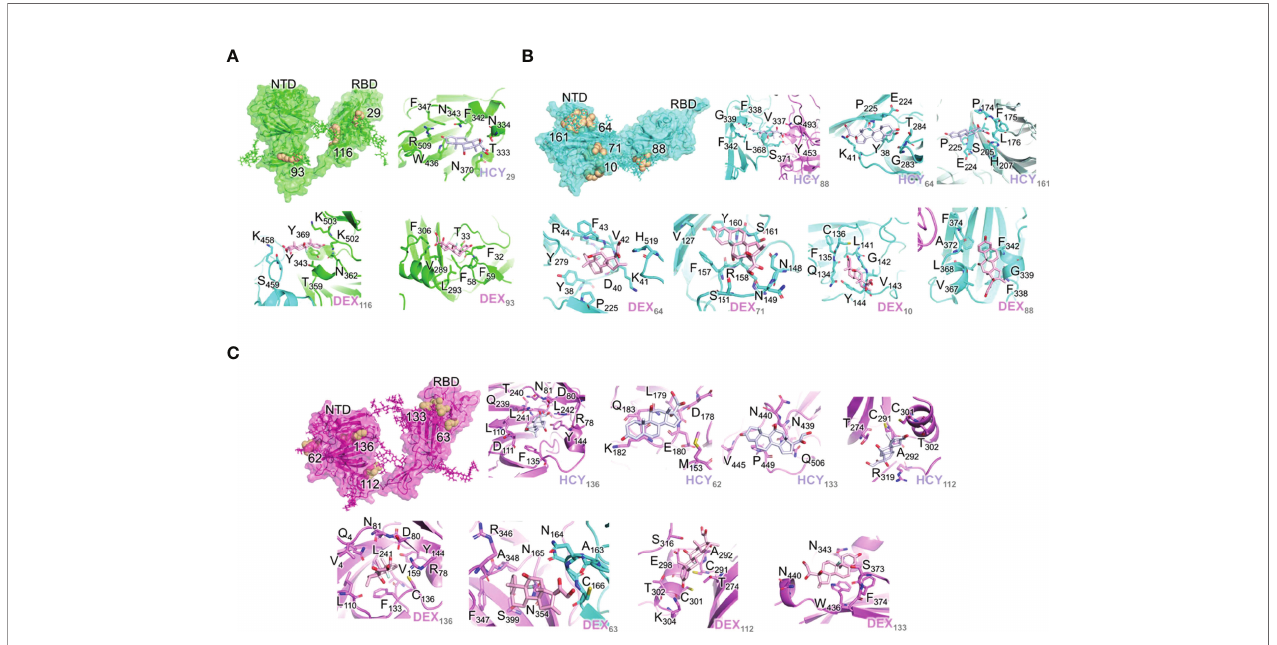
FIGURE 1 | Interactions of the ligand/pocket pairs in chain A (green), chain B (cyan) and chain C (magenta) of the S1 protein . (A) The pockets on each chain A were ranked according to the binding af fi nity. The pockets where the ligands are predicted to bind with a higher af fi nity (>13 kcal/mol) after MD simulation are shown ( Table 1 ). From left to right: High af fi nity binding pockets for cortisol and dexamethasone; Cortisol pocket 29; Dexamethasone pocket 116; Dexamethasone pocket 93. (B) The pockets on chain B were ranked according to the binding af fi nity. The pockets where the ligands are predicted to bind with a higher af fi nity (>13 kcal/ mol) after MD simulation are shown ( Table 3 ). From left to right: High af fi nity binding pockets for cortisol and dexamethasone; Cortisol pocket 88; Cortisol pocket 64; Cortisol pocket 161; Dexamethasone pocket 64; Dexamethasone pocket 71; Dexamethasone pocket 10. Dexamethasone pocket 88. (C) The pockets on chain C were ranked according to the binding af fi nity. The pockets where the ligands are predicted to bind with a higher af fi nity (>13 kcal/mol) after MD simulation are shown ( Table 2 ). From left to right: High af fi nity binding pockets for cortisol and dexamethasone; Cortisol pocket 136; Cortisol pocket 62; Cortisol pocket 133;